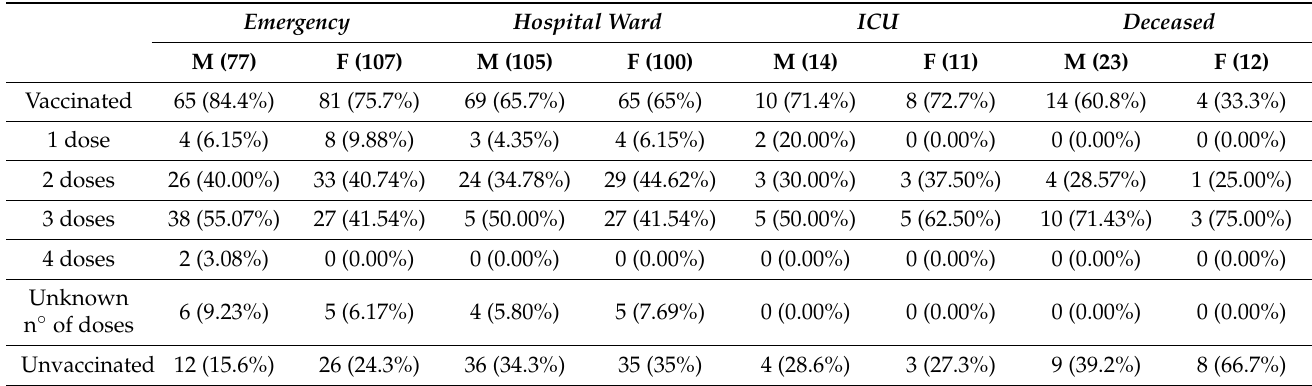
Table 1. Doses of vaccines in the recruited